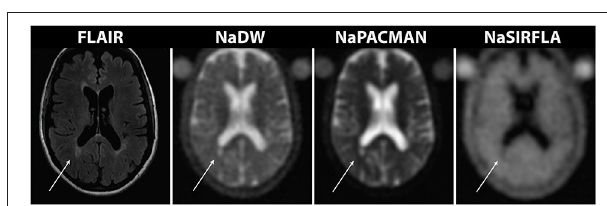
FIGURE 2 | Images from a 58 year old female RRMS patient highlight image intensity differences between the three sodium MRI sequences. The lesion identified with the arrow exhibits greater signal enhancement on NaPACMAN than NaDW, while the same lesion has lower image intensity on